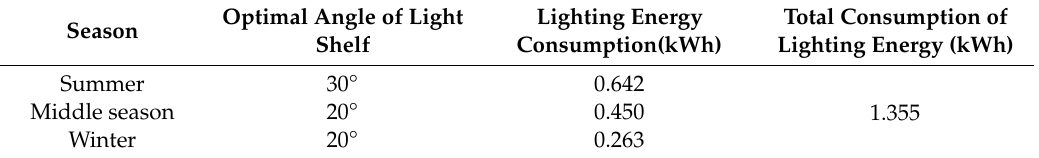
Table 7. Optimal specifications and lighting energy consumption of the flat light shelf.